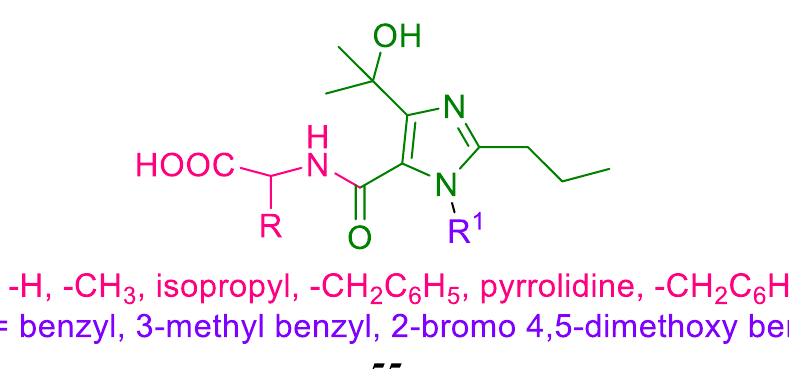
Figure 50. Imidazole-amino acids